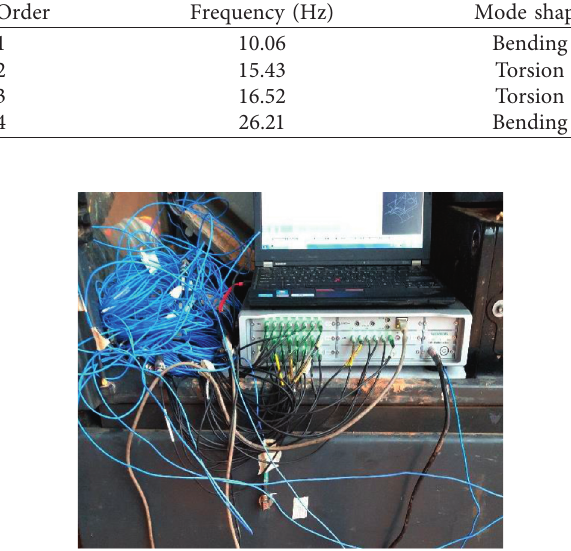
Figure 4: Vibration test site diagram.